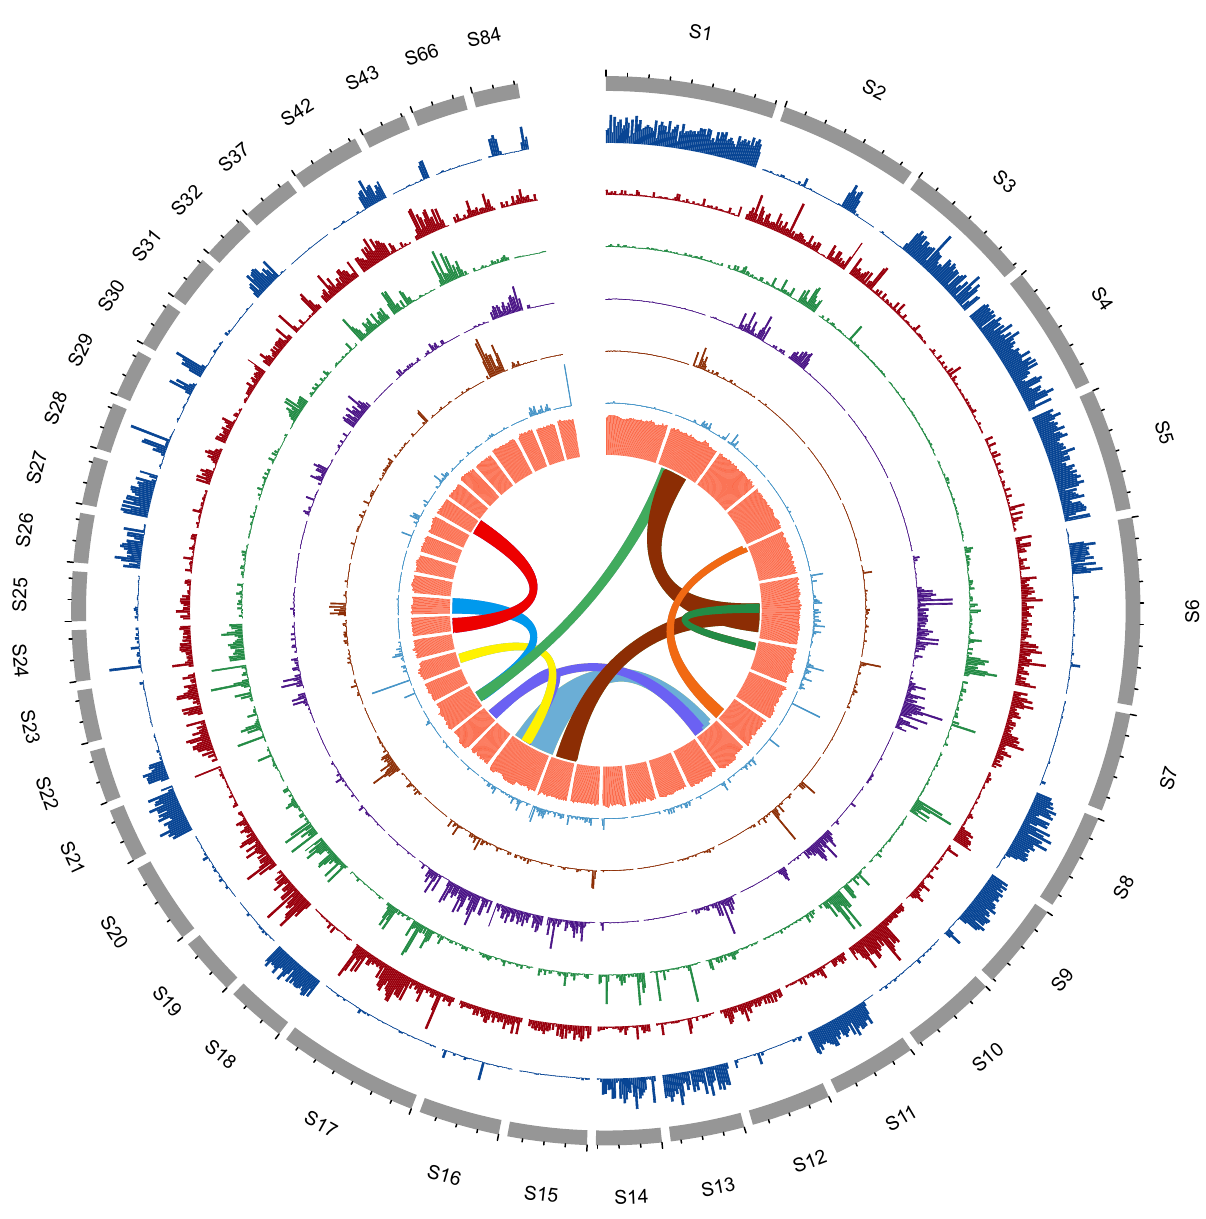
Fig. 1 Circular overview of the T. hydatigena genome. Circular overview plot shows basic features across the T. hydatigena genome assembly. From outermost to innermost ring: density of gene models, density of long terminal repeat retrotransposons, density of DNA transposons, density of short interspersed nuclear elements, density of long interspersed nuclear elements, density of non-coding RNA, % of GC, and segmental duplications ( ≥ 5 genes in a block). All tracks except scaffold alignments show binned data with a window size of 0.1 Mb. Only scaffolds with ≥ 13.5 Mb in length are